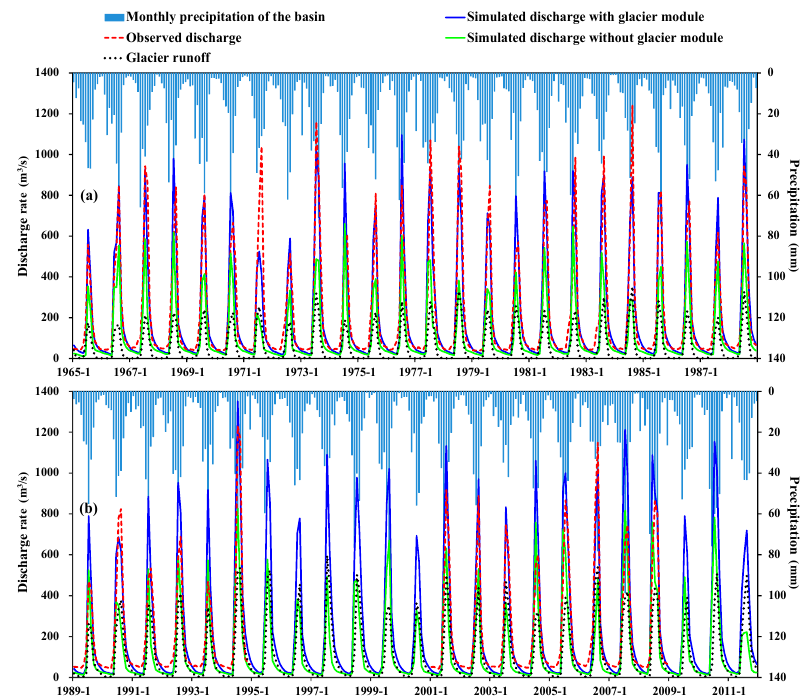
Figure 4. Comparison of simulated versus measured monthly streamflow processes; ( a ) Calibration period: January 1965 to December 1988; ( b ) Validation period: January 1989 to December 2011; with measured data missing in the periods from January 1995 to December 2000, and January 2009 to December 2011. Water 2017 , 9 , 159